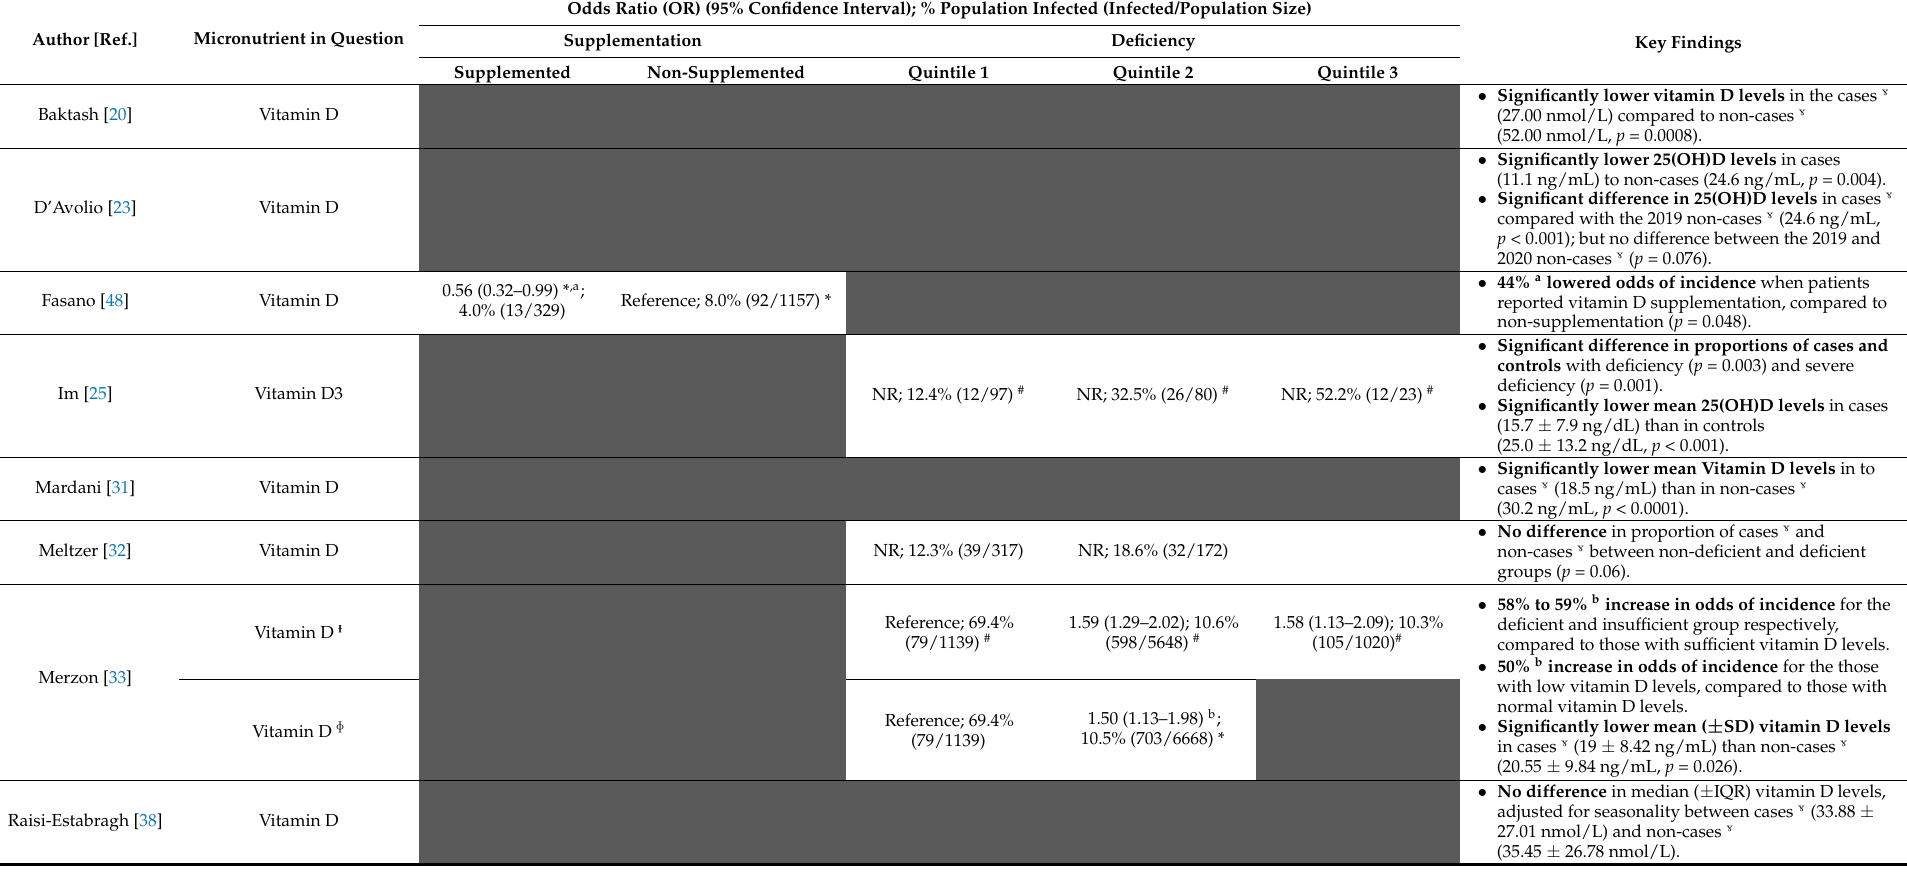
Table 3. COVID-19 Incidence as